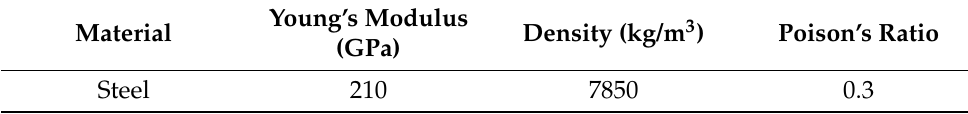
Table 3. Material properties of the FEA